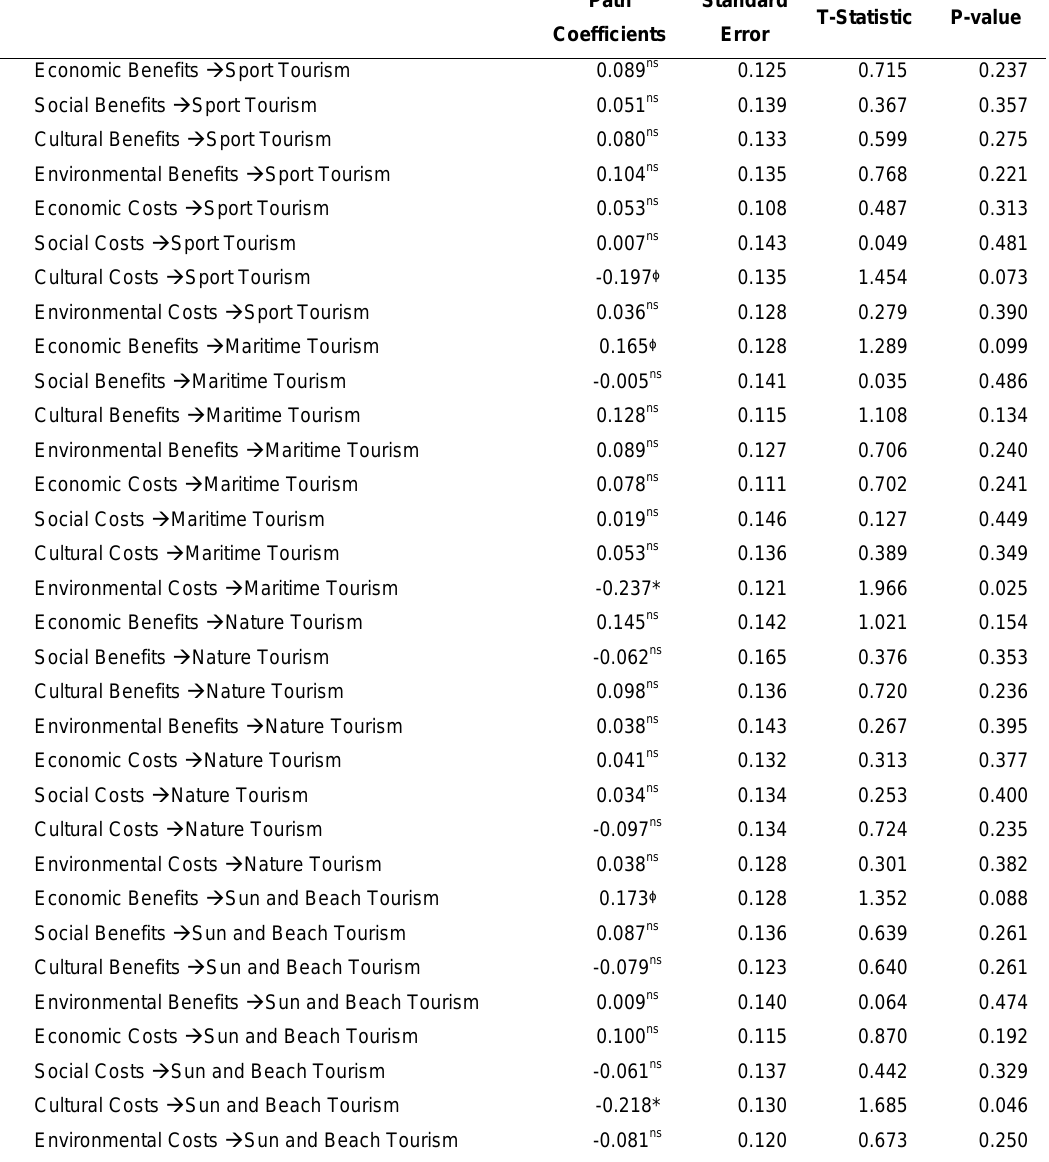
Table 6. Hypotheses summary